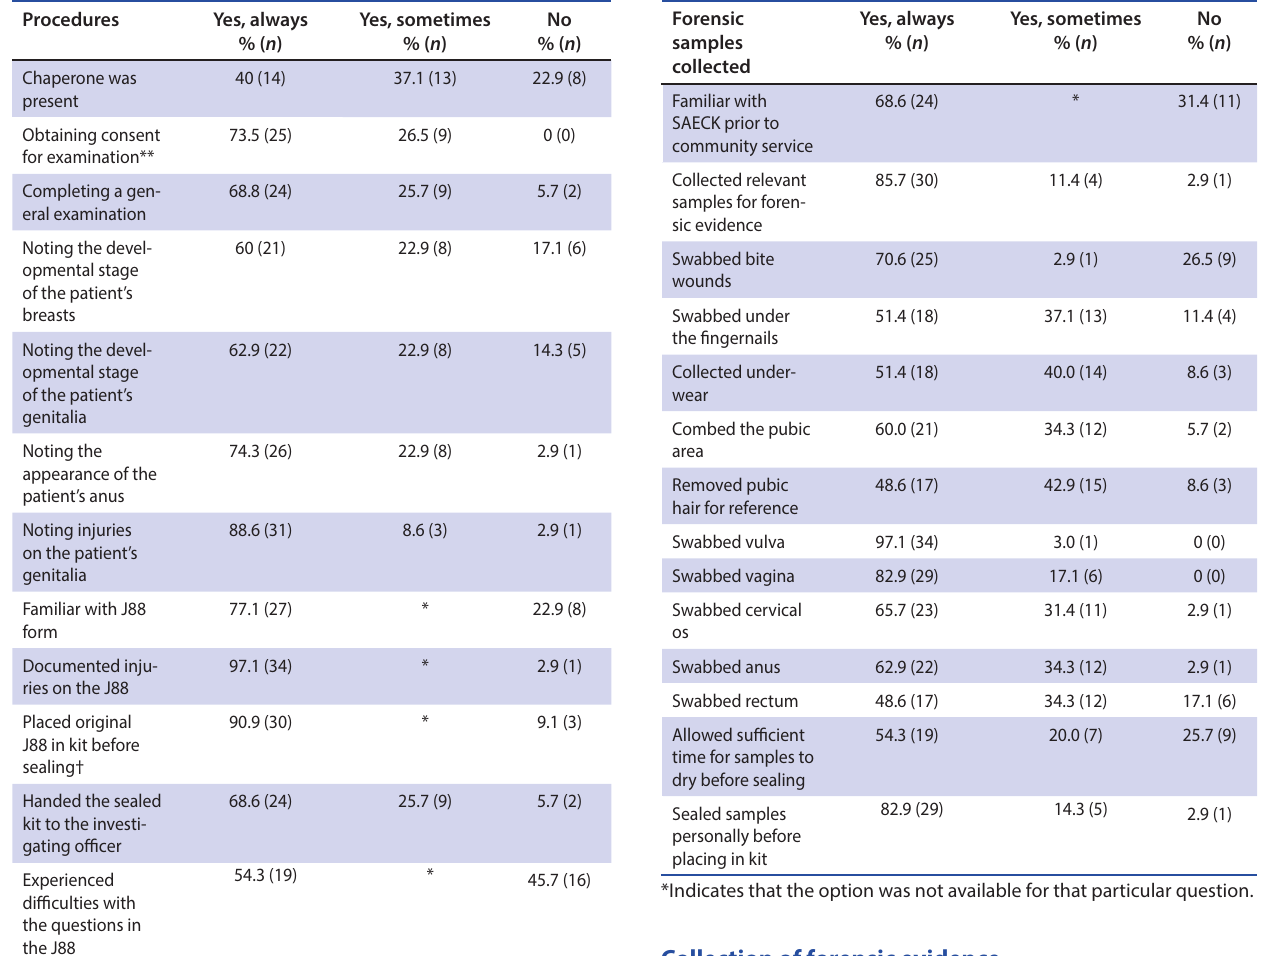
Table 4: Adhering to procedures for collecting and handling forensic evidence ( n = 35)